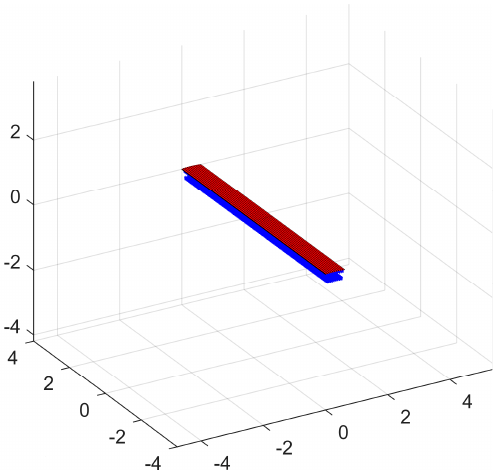
Figure A1. Vortex lattice distribution of the flat wing with airfoil (GA(W)-1) and 20% plain flap. Table A1. Reference quantities and flow conditions.